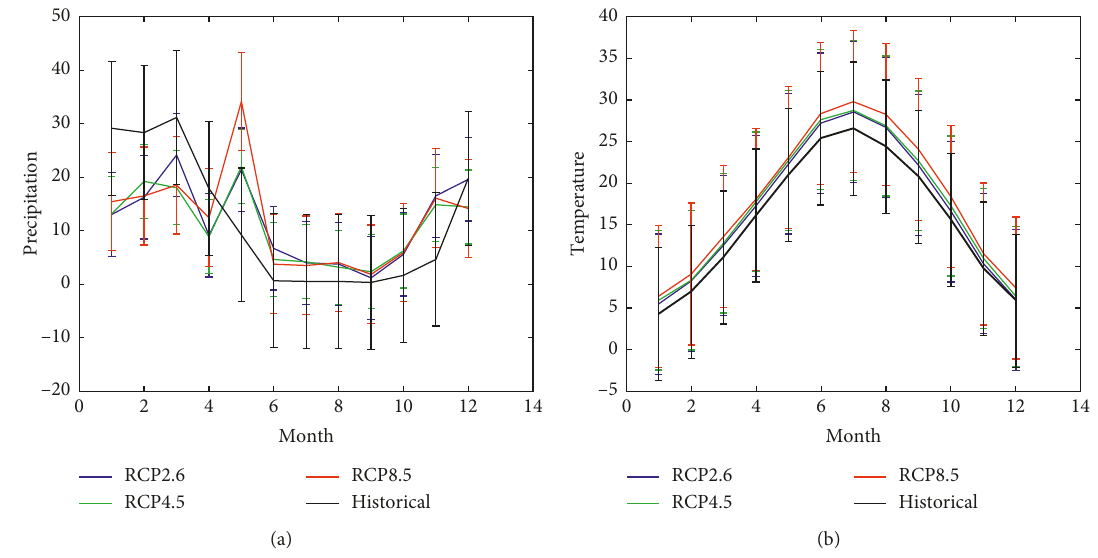
Figure 4: Error bar of mean monthly precipitation (a) and temperature (b) in historical and future